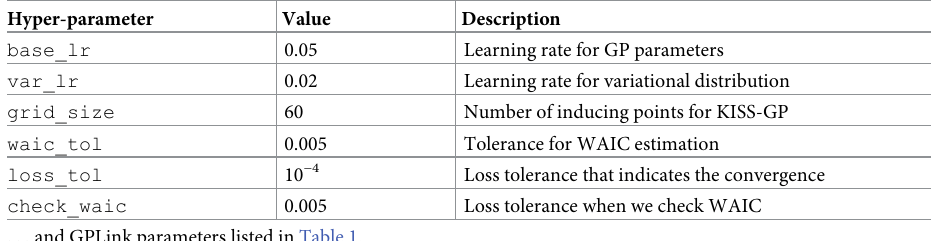
Table 3. Hyper-parameters of the bivariate Copula-GP model. Hyper-parameter Value Description base_lr 0.05 Learning rate for GP parameters var_lr 0.02 Learning rate for variational distribution grid_size 60 Number of inducing points for KISS-GP waic_tol 0.005 Tolerance for WAIC estimation loss_tol 10 − 4 Loss tolerance that indicates the convergence check_waic 0.005 Loss tolerance when we check WAIC ... and GPLink parameters listed in Table